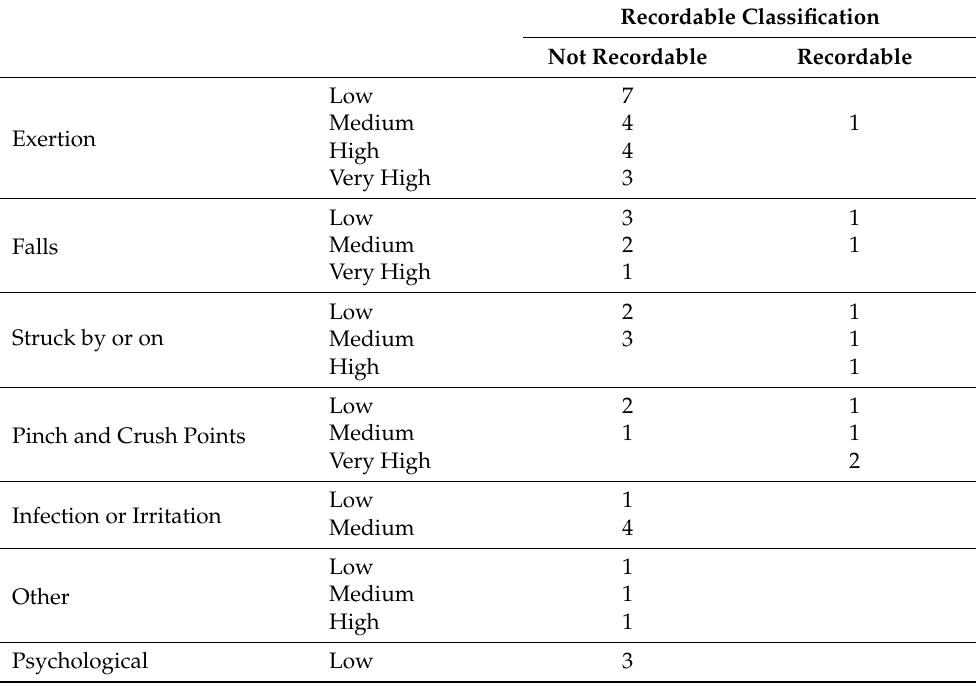
Table 7. Injuries by mechanism and recordable